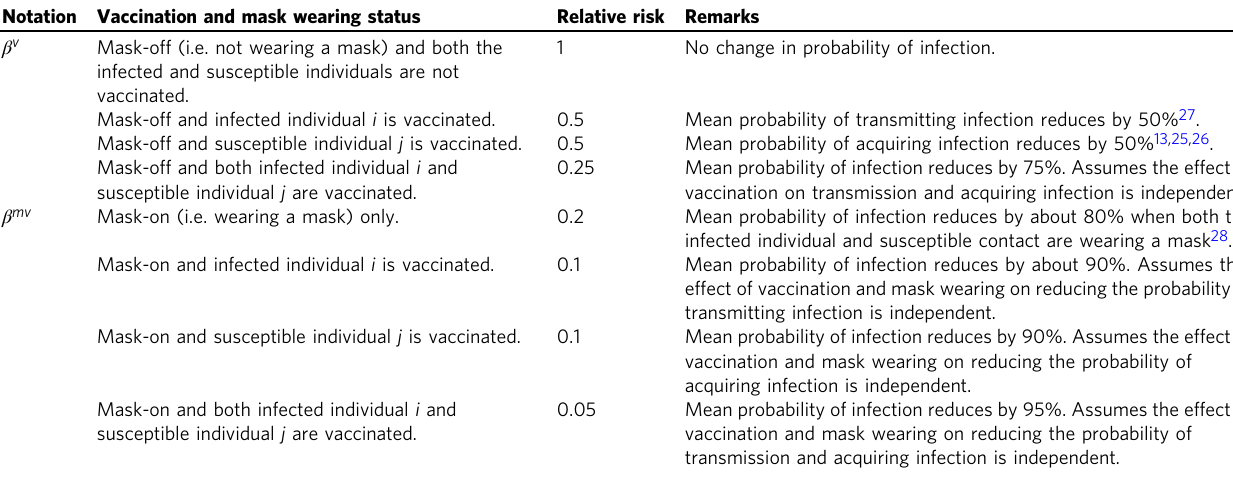
Table 4 Parameter values for the relative risk of infection, β